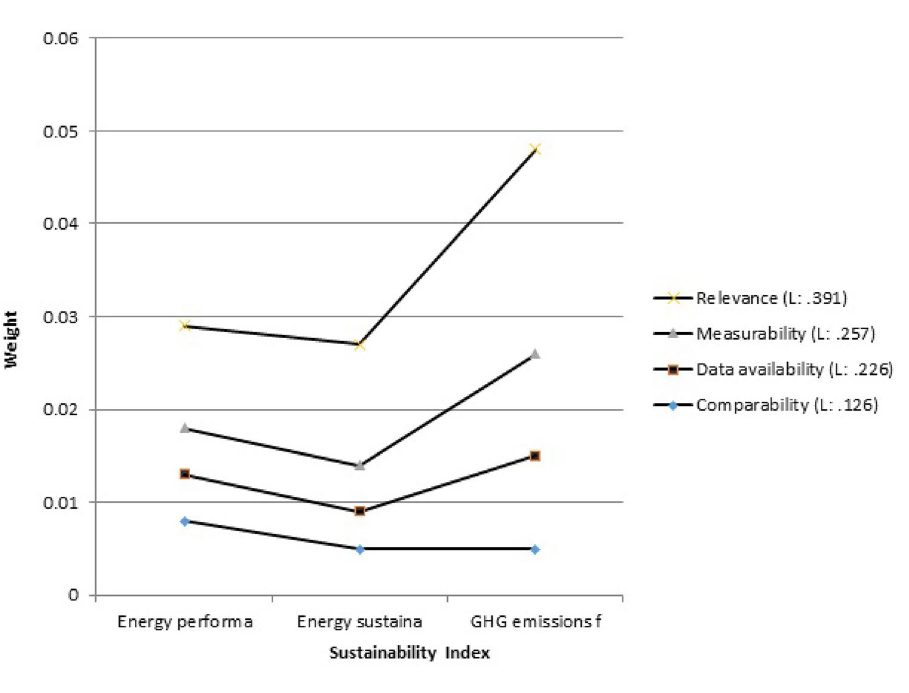
Figure 6. Energy sustainability